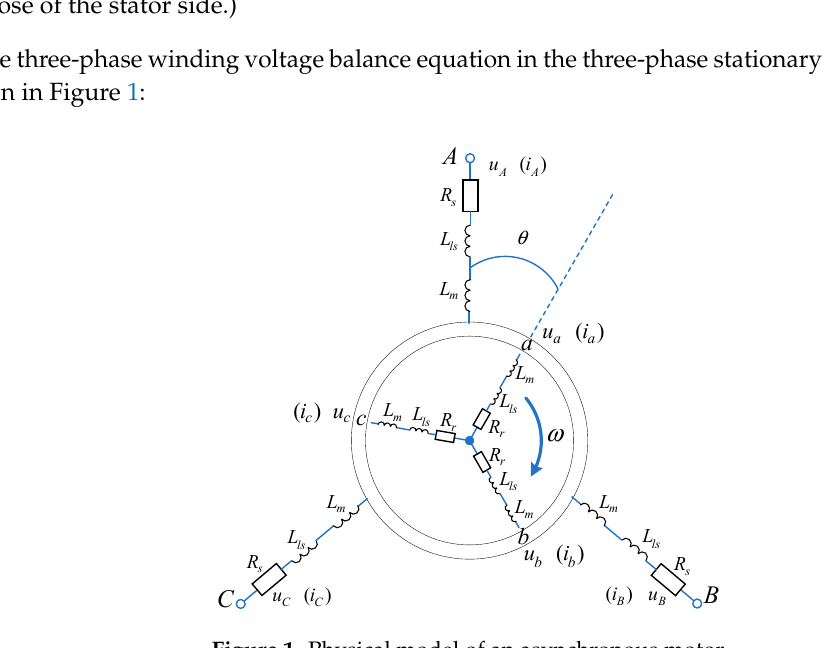
Figure 1. Physical model of an asynchronous motor.